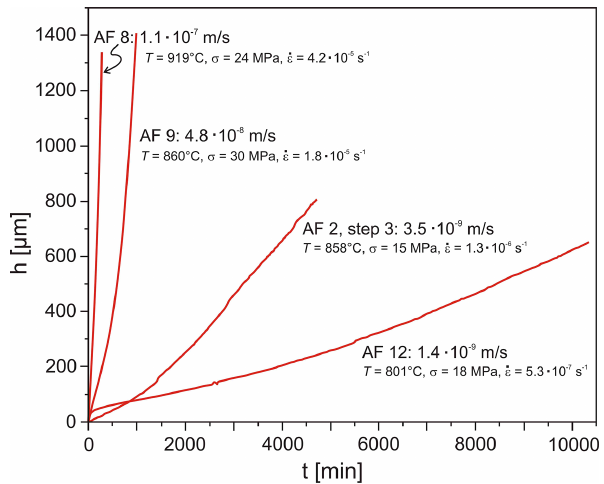
Figure 5. Exemplary creep curves (displacement h versus time t ) for four of the experiments listed in Table 1. After a transient stage lasting up to 3 to 4 days, steady state is achieved, with a slope con- trolled by load and